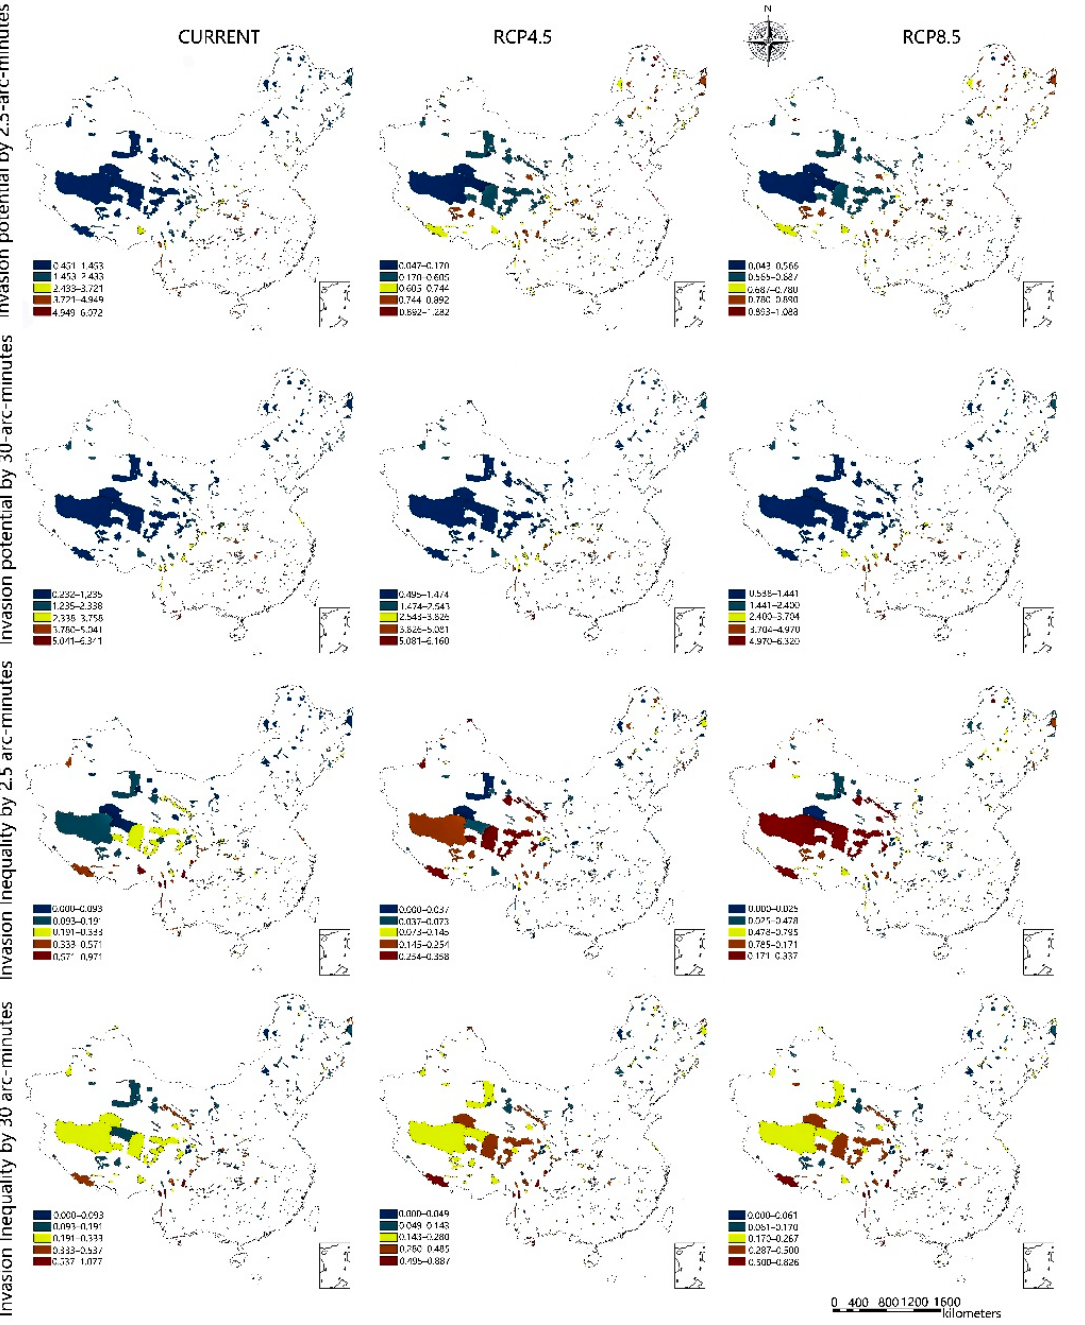
Figure 5. The potential of IAPS-invaded protected areas and the inequality of IAPS-invaded protected areas at both 2.5 arcminutes and 30.0 arcminutes under climate change. Current: the present day; RCP4.5: low-gas-concentration scenario; RCP8.5: high-gas-concentration scenario.